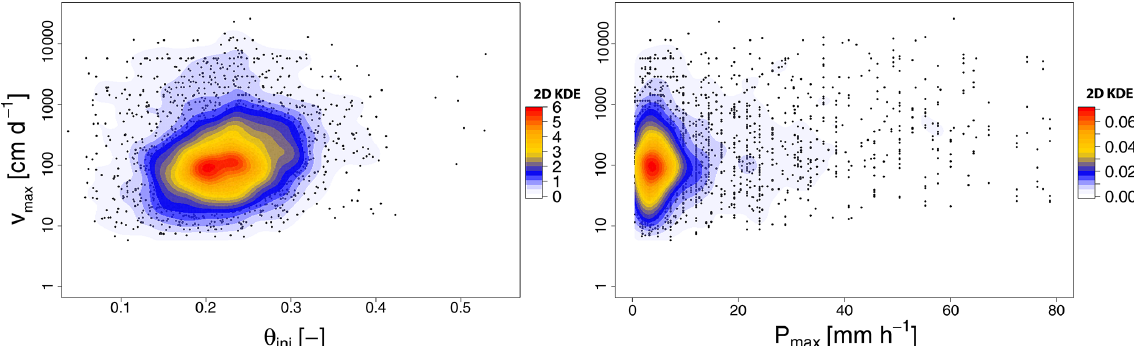
Figure 9. Measured SR maximum porewater velocities ( v max ) in relation to θ ini and P max . Color contours indicate 2-D kernel density estimation (2-D KDE). The points show single event values.